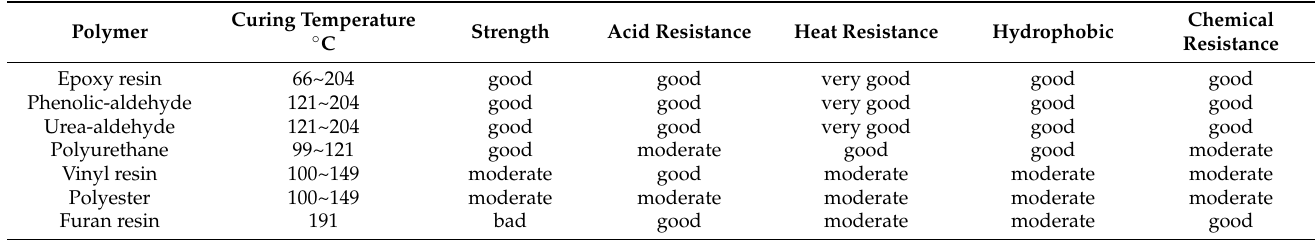
Table 3. Properties for the polymers used in the proppant coating.